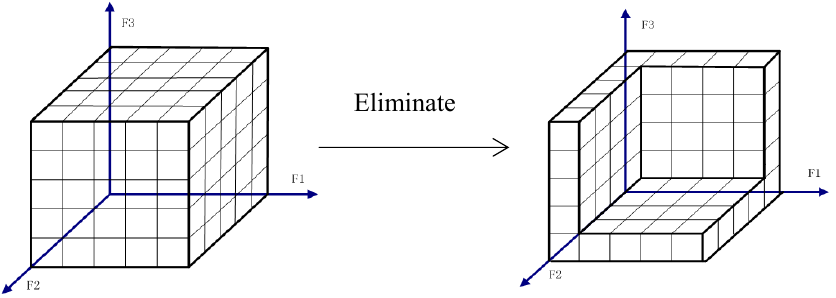
Figure 1. The schematic diagram of iterated elimination of strictly dominant strategies.